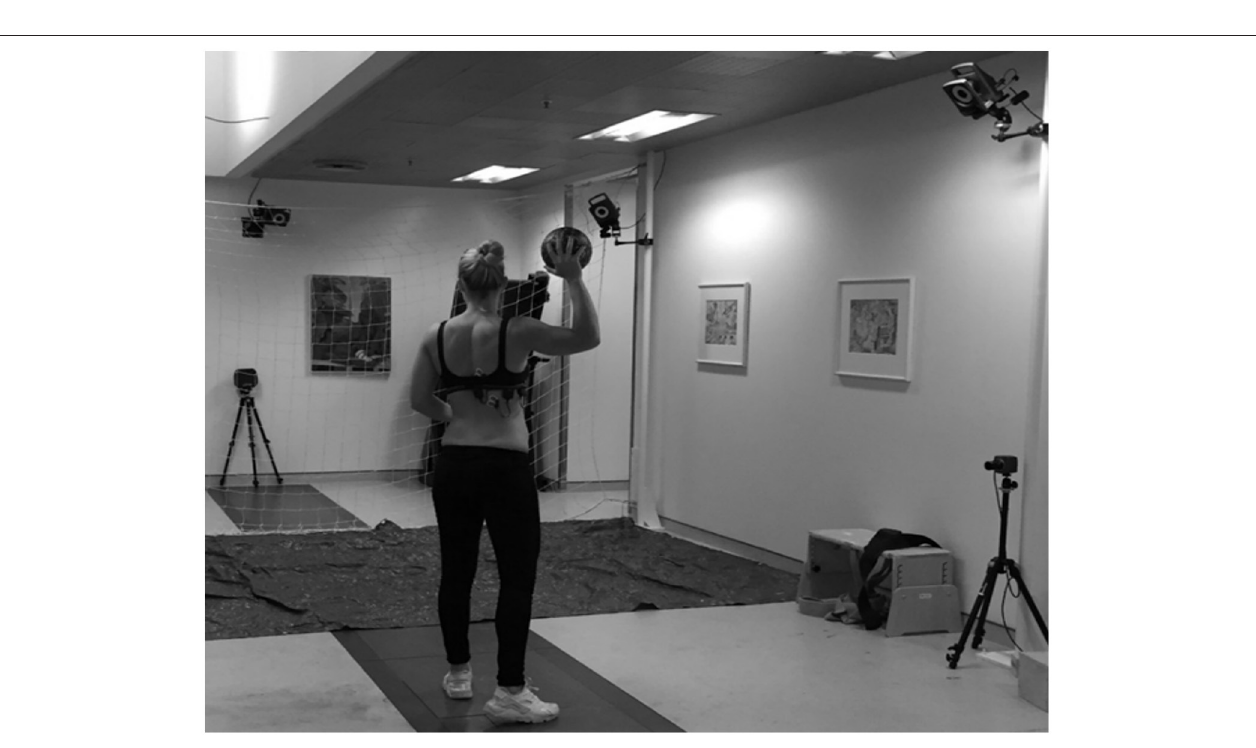
FIGURE 2 | Measurement of shoulder kinematics and muscle activity during maximum